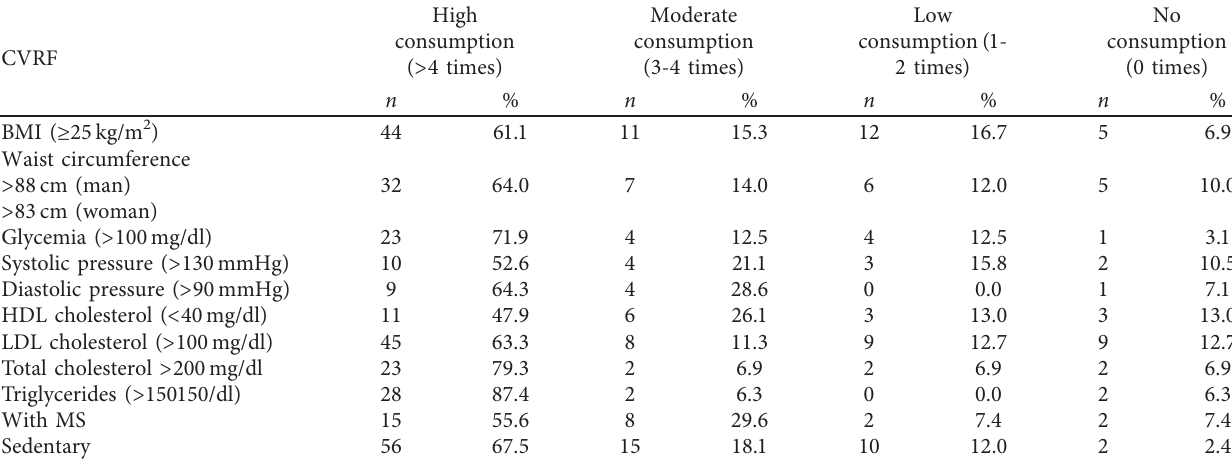
Table 4: The prevalence of elevated values of CVRF according to the frequency of consumption of fried foods monthly.